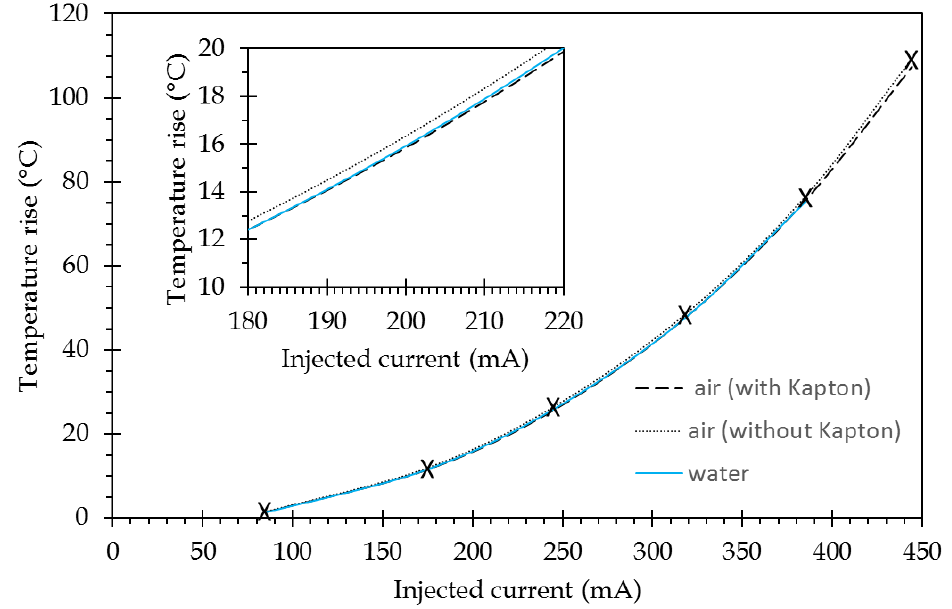
Figure 8. Comparison of the temperature rise versus the injected current for different experimental conditions: air without Kapton and air with Kapton for temperature measurements, and water for SPR measurements. Crosses indicate modeling points, while lines are the polynomial approximations that are used in the modeling (see Section 3.2.2). The insert is a zoom exhibiting the slight differences between those different cases.